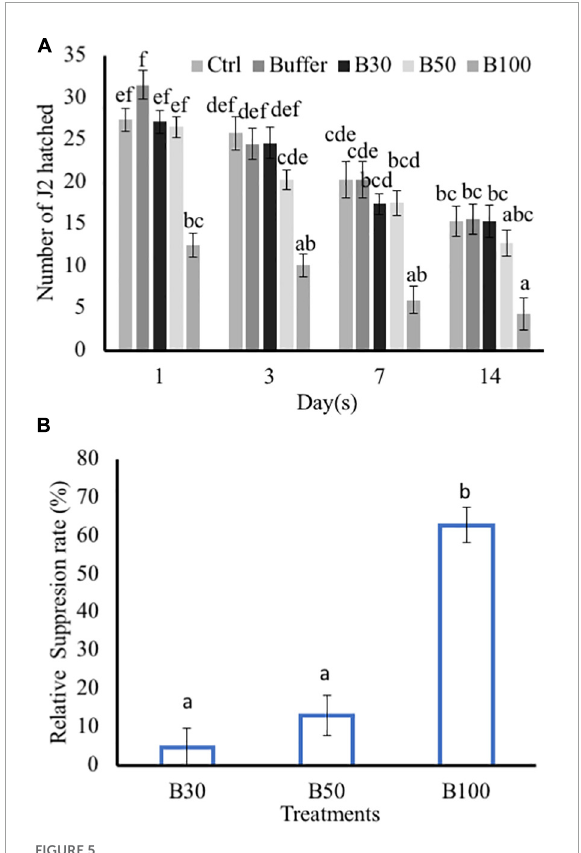
FIGURE5 Effect of P. polymyxa strain LMG27872 on hatching of M. incognita in vitro. The effect of different bacterial suspension doses (30, 50, and 100%) on hatching of M. incognita eggs. (A) Number of J2 hatched counted at respective time points and (B) relative suppression rate of M. incognita egg hatching. Data were analyzed by one-way ANOVA, followed by Tukey’s post-hoc test; data are shown by box plots with median, and upper and lower quartiles. Different letters indicate statistically different means at (95%